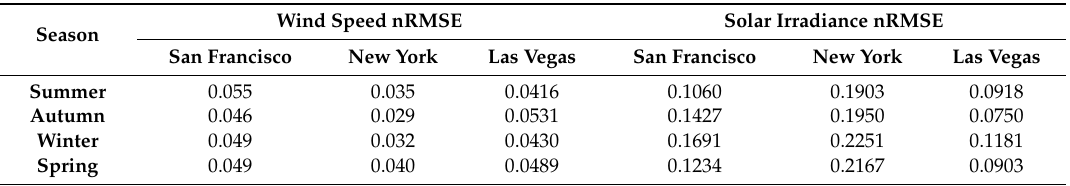
Table 9. E ff ectiveness of proposed model in di ff erent